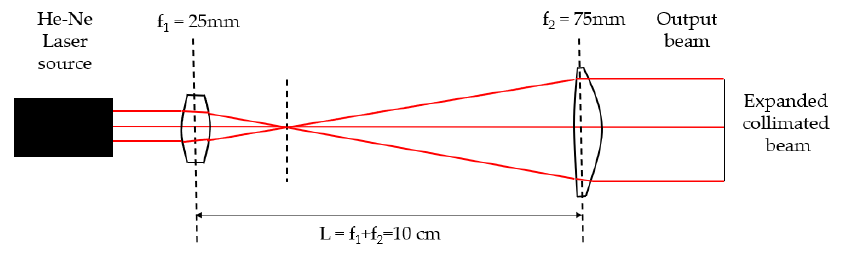
Figure 1. Helium-neon laser ( λ = 632.8 nm) beam expansion setup.